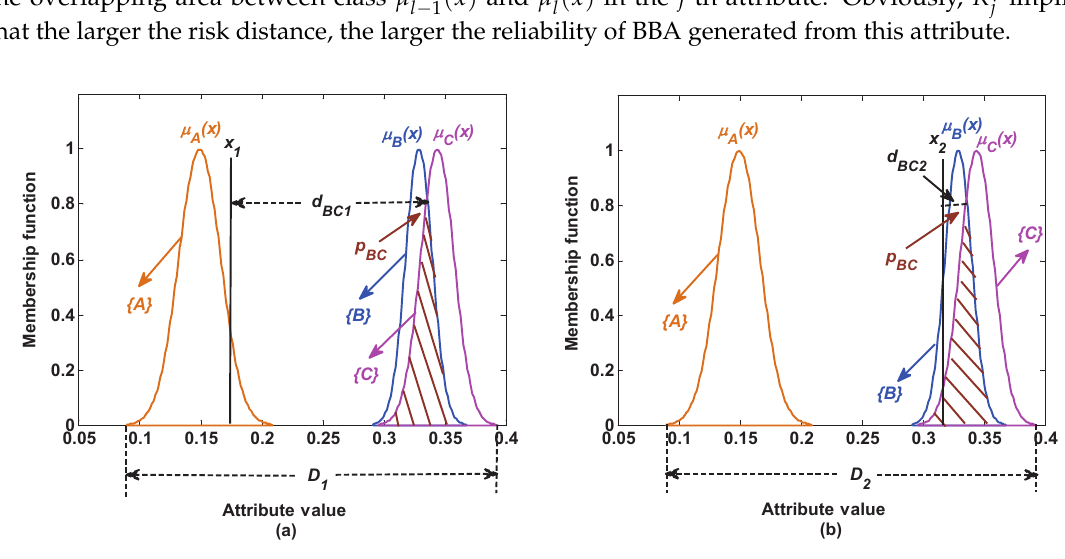
Figure 5. Reliability measure based on the dynamic test